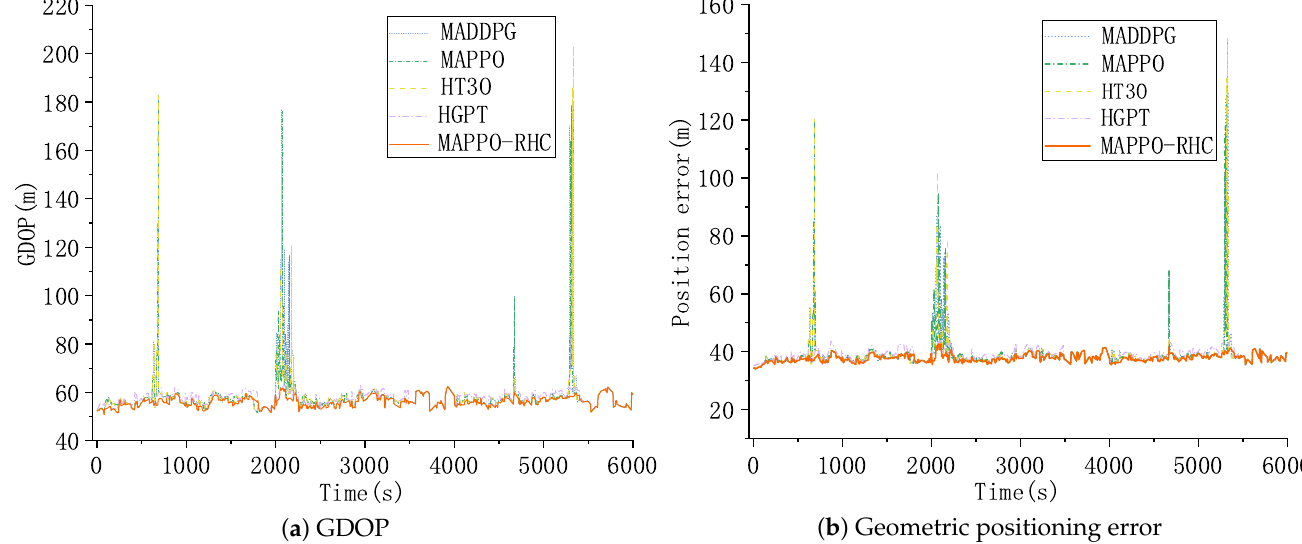
Figure 12. GDOP and geometric positioning accuracy.